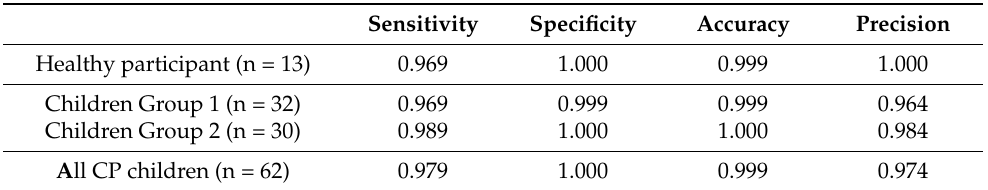
Table 2. Sensitivity, specificity, accuracy and precision of step detection with HoloStep algorithm for healthy participants and children with CP.